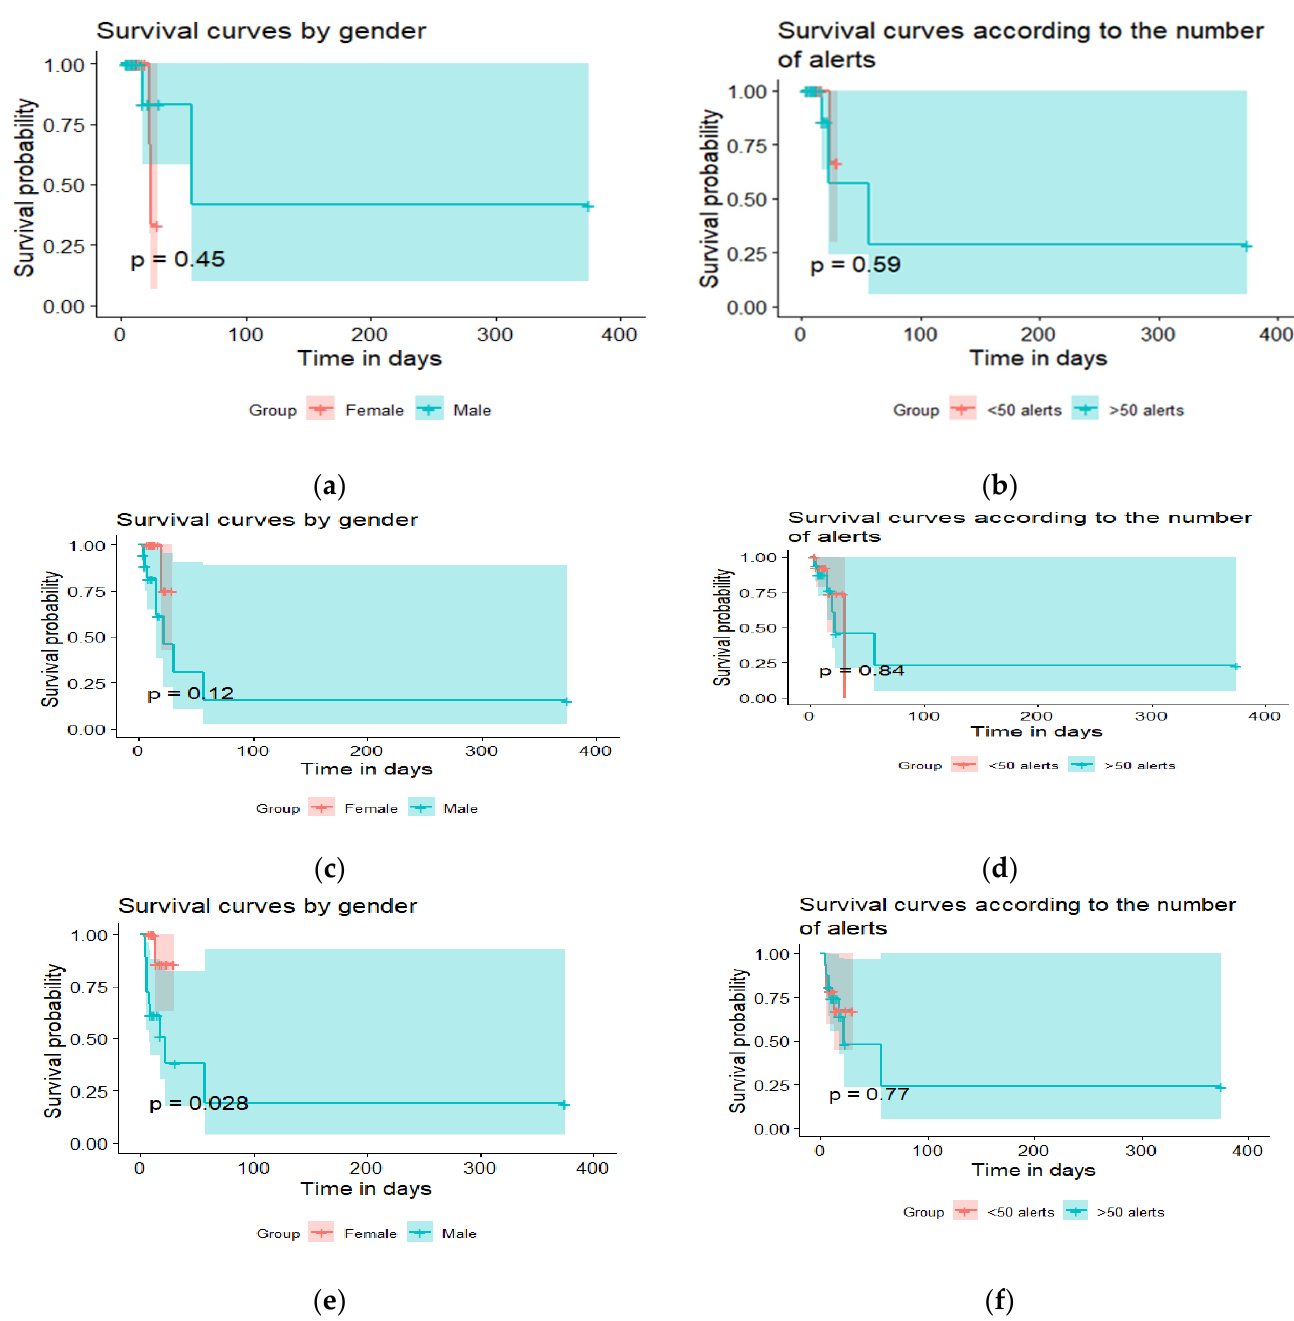
Figure 1. Survival analysis. ( a ) Survival curves by gender following cardiac decompensation. ( b ) Survival curves by number of alerts following cardiac decompensation. ( c ) Survival curves by gender following alteration of general health. ( d ) Survival curves by number of alerts following alteration of general health. ( e ) Survival curves by gender following death. ( f ) Survival curves by number of alerts following death.